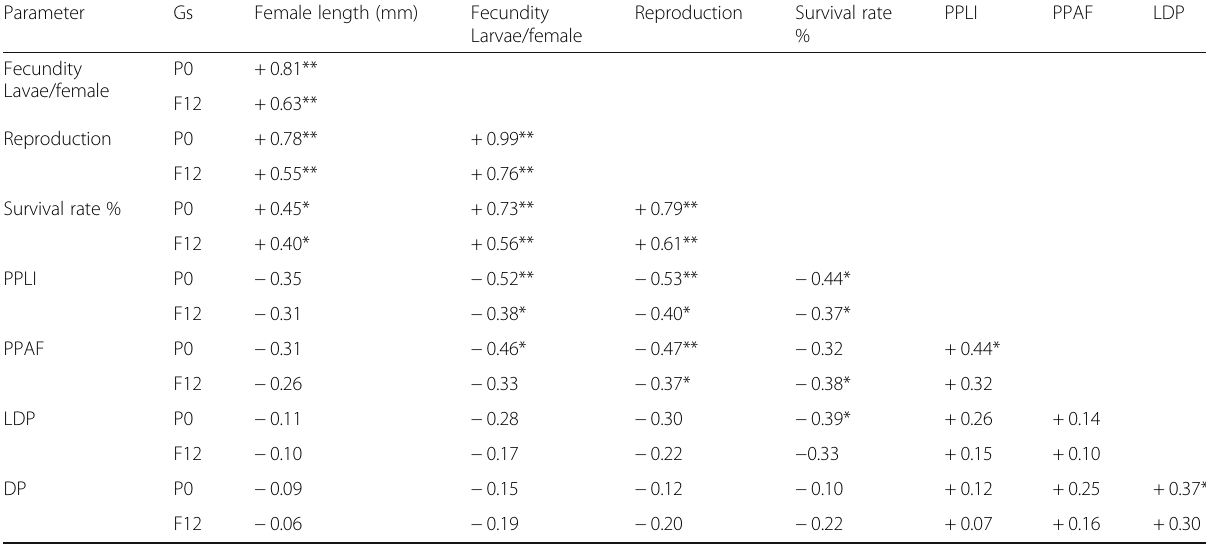
Reproduction Survival rate PPLI PPAF LDP Larvae/female %